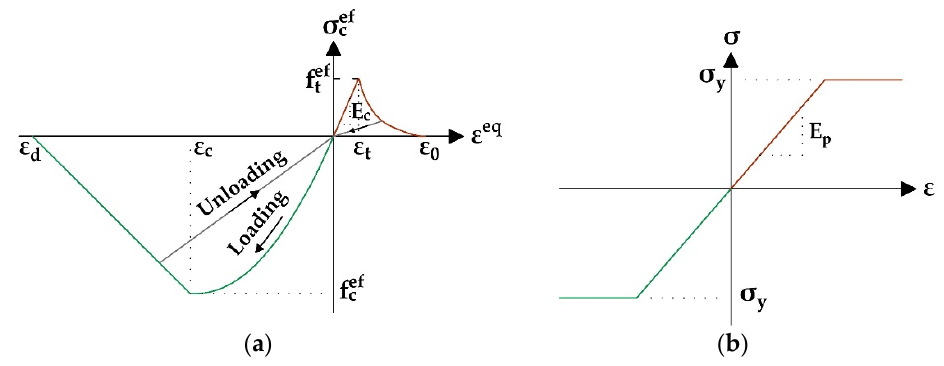
Figure 17. Uniaxial stress–strain curve for concrete ( a ); stress–strain curve for wires ( b ) [40].